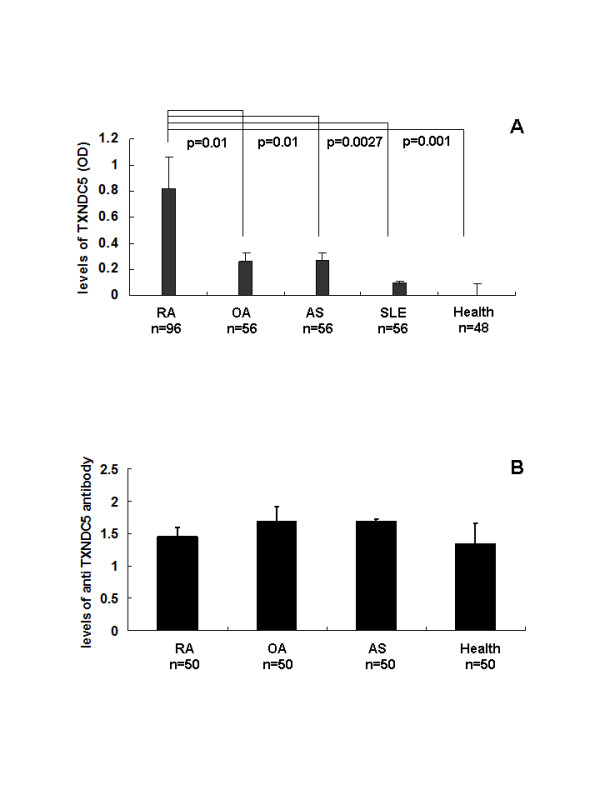
Serum levels of TXNDC5 and anti-TXNDC5 antibody in patients with arthritic diseases and healthy controls. TXNDC5 levels are represented by OD values of absorbance at 405 nm and are expressed as the mean ± standard error of the mean. (A) A sandwich ELISA detected increased level of TXNDC5 in blood samples from RA patients compared to samples from OA, AS and SLE patients, as well as from healthy controls. (B) An ELISA indicated that levels of anti-TXNDC5 antibodies were not significantly different among blood samples from RA, OA and AS patients and the healthy controls. AS, ankylosing spondylitis; OA, osteoarthritis; RA, rheumatoid arthritis.